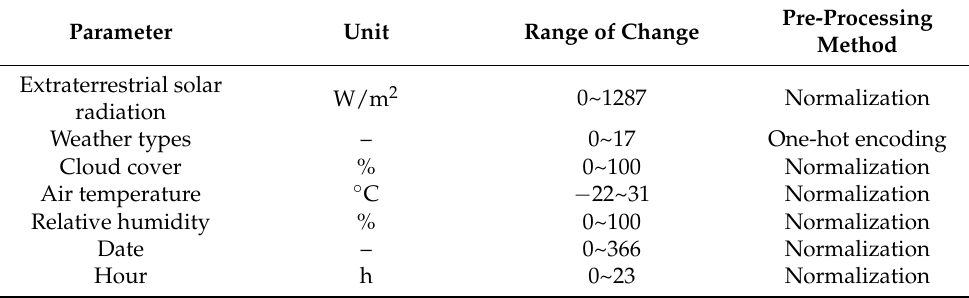
Table 2. Statistical table of the model input parameters. Parameter